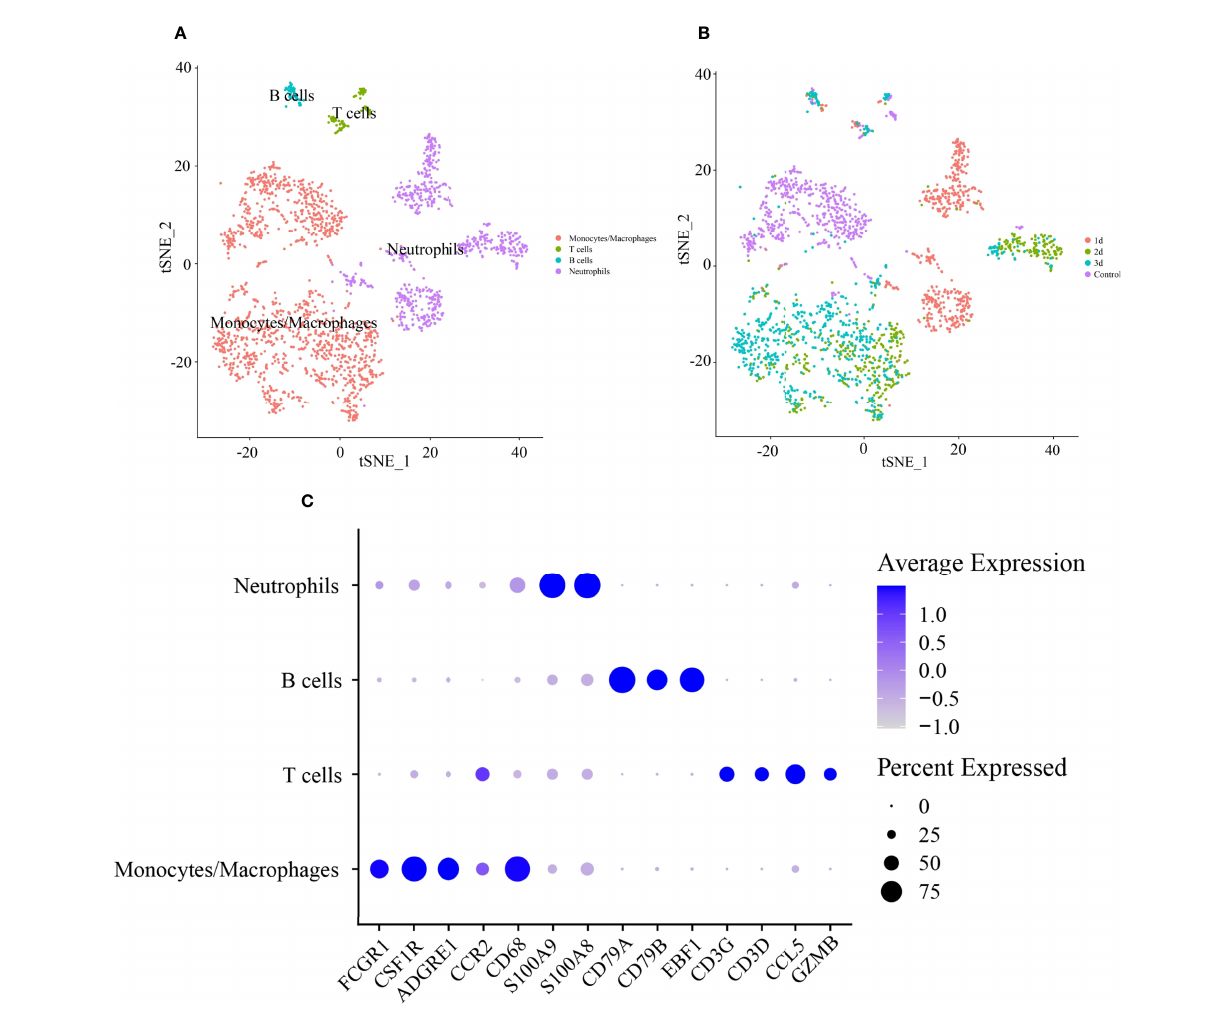
FIGURE 5 | Identi fi cation of cell type of CD45+ lymphocytes in infarcted cardiac tissues of mice. (A) tSNE visualization of cell type in heart tissues of control and infarcted mice. (B) tSNE visualization of lymphocytes in heart tissues of control mice at 1 day (1 d), 2 days (2 d) and 3 days (3 d) after AMI. (C) Dot plot of canonical markers of different cell types. Dot size re fl ects the percentage of cells expressing the markers in each cell type. The scale color represents the gene expression levels from low to